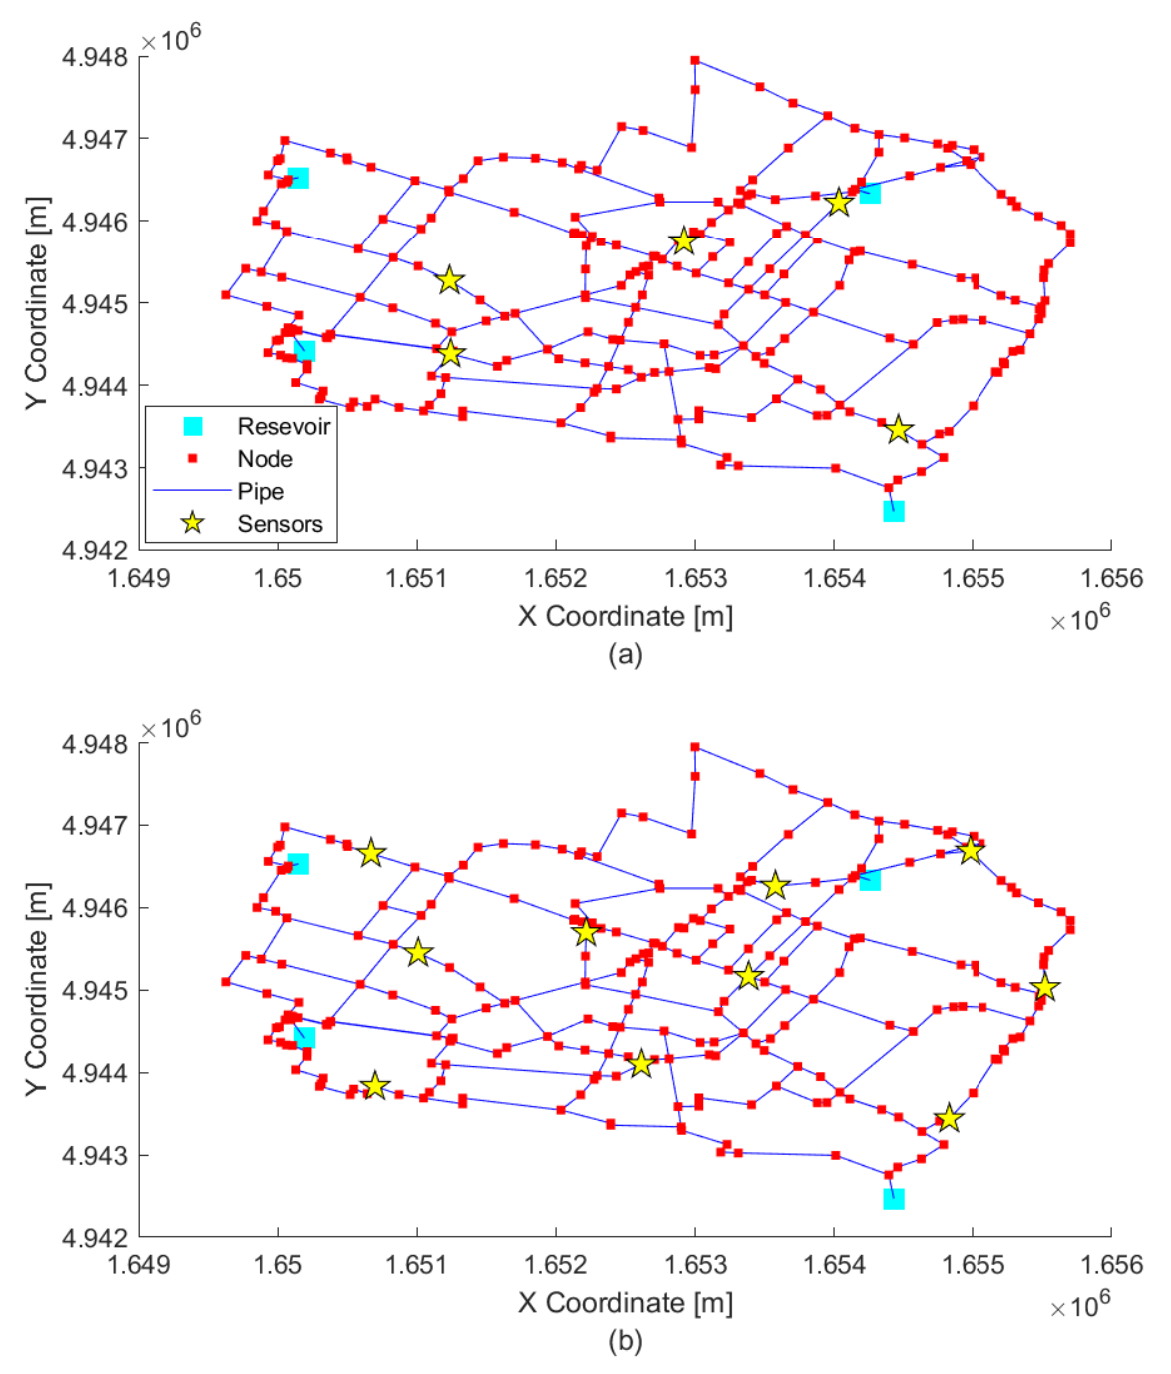
Figure 8. Configuration of pressure sensors in Modena WDN: ( a ) 5 sensors, ( b ) 10